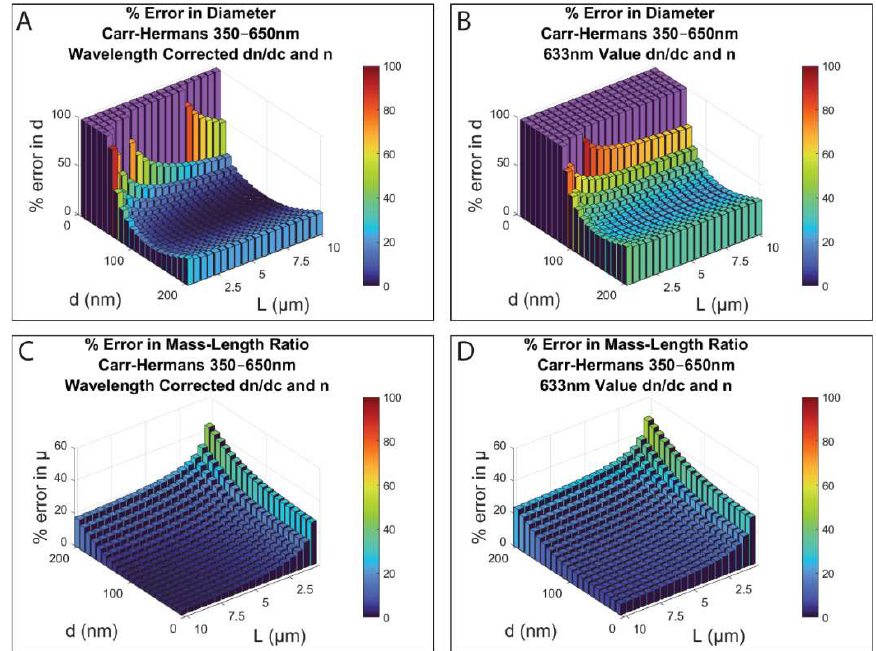
Figure 4. Percent error in diameter ( A , B ) and in mass–length ratio ( C , D ) between the values obtained from fitting the Carr–Hermans approach to the full light scattering theory dataset and the values used to create the initial dataset for lengths of 0.5–10 μm and diameters of 10–200 nm. In ( A , C ), the wavelength dependence of n and dn/dc was accounted for (Equations (20) and (21); in ( B , D ), constant values for n and dn/dc at 633 nm were used. (c = 0.0001 g/cm 3 , μ = 4.73 × 10 12 Da/cm, HBS buffer; the purple bars represent imaginary diameter values calculated from the fit and were assigned a value of 100% error for plotting purposes; note that ( A , B ) have a different viewing angle to ( C , D ). Table 1. Average difference in percent error for diameter and mass–length ratio calculated from numerical simulations with constant values of n and dn/dc (values at 633 nm) and wavelength- dependence corrected values of n and dn/dc (for HBS